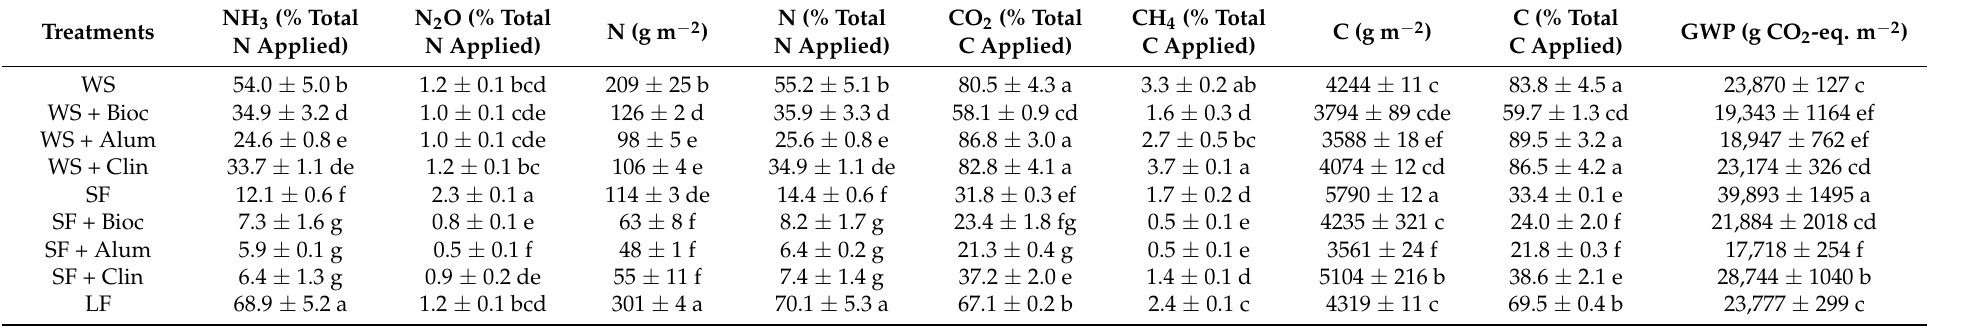
Table 3. Cumulative nitrogen and carbon emissions from each treatment (mean ± standard deviation) ( n =